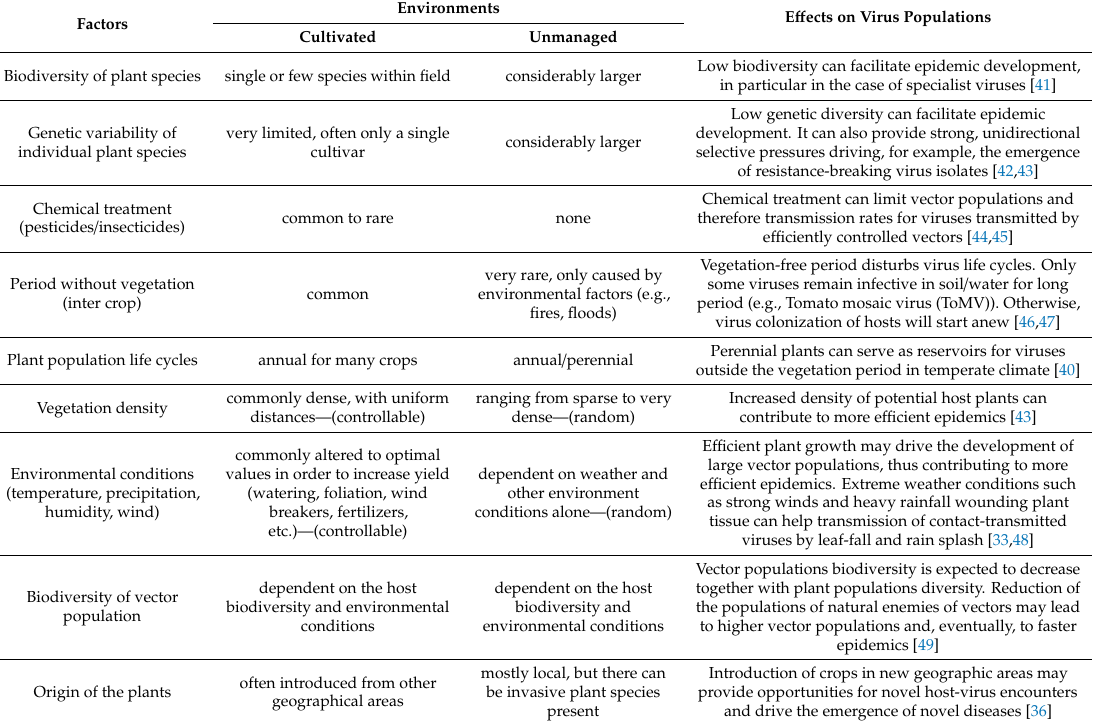
Table 1. Comparison of cultivated and unmanaged environments, focusing solely on solanaceous plants and viral pathogens infecting them. Environments E ff ects on Virus Populations Factors Cultivated